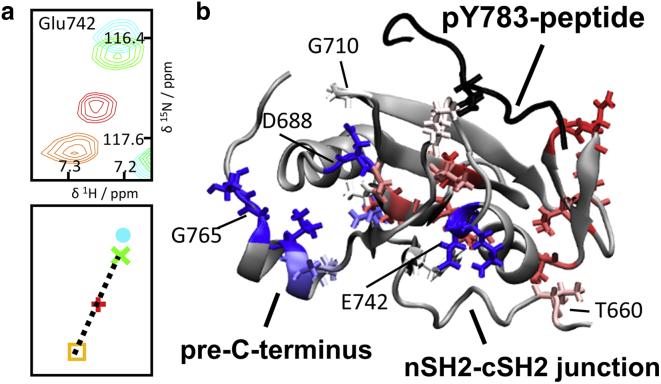
C-terminal-linker-dependent and C-terminal-linker-independent contributions to allosteric communication. (a) Superposition of 1H,15N-HSQC NMR spectra and corresponding schematic representation of the crosspeak centroids for residue Glu742 are shown. The color scheme is as depicted in Fig. 3. The crosspeaks for NSH2CSH2-pY783 and NSH2CSH2ΔCT-CTpY are shifted in opposite directions along the “fast-exchange vector,” exposing a differential impact of allosteric influences. (b) Depiction of the cSH2 domain illustrates how the Tyr783 status is communicated via two distinct allosteric pathways (the C-terminal linker is not shown; pY783-peptide is in black). The communication type is graded by color: C-terminal-linker-independent allosteric pathway in red—via white—to C-terminal-linker-dependent communication in blue. Only residues with data are displayed in stick model form. The communication type was determined by the projection of the NSH2CSH2ΔCT-CTpY peak on the vector connecting the NSH2CSH2-pY783 and NSH2CSH2ΔCT crosspeaks.